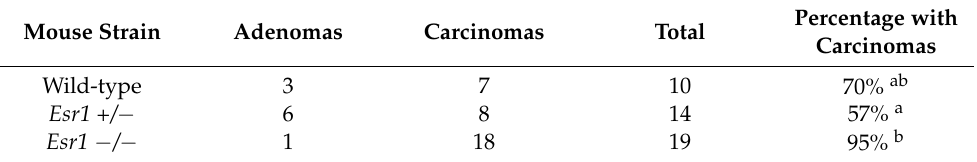
Table 2. Effect of Estrogen Receptor- α on tumor progression in